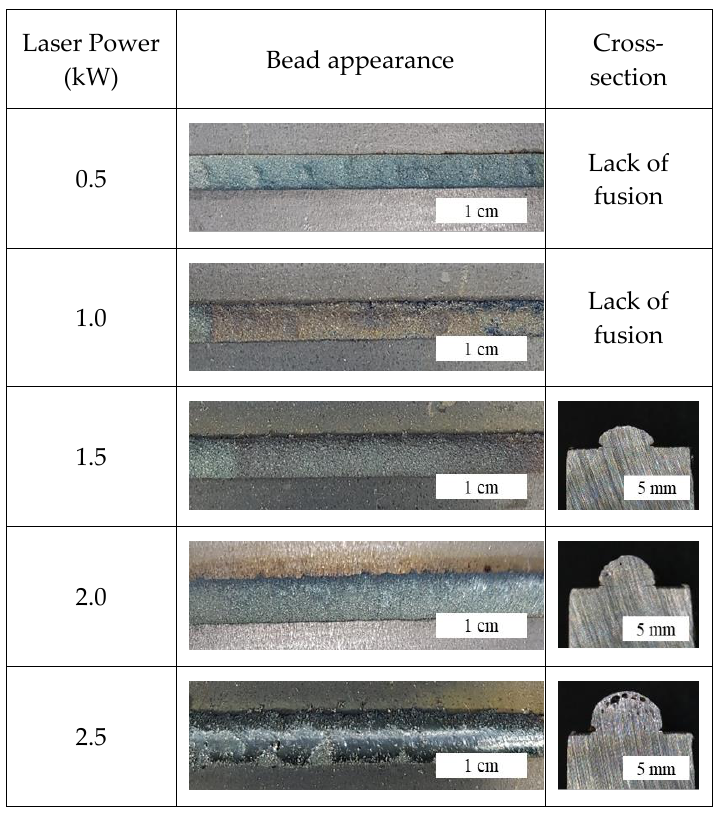
Figure 7. Bead appearance and cross-section of bead with various laser power from 0.5 kW to 2.5 kW.